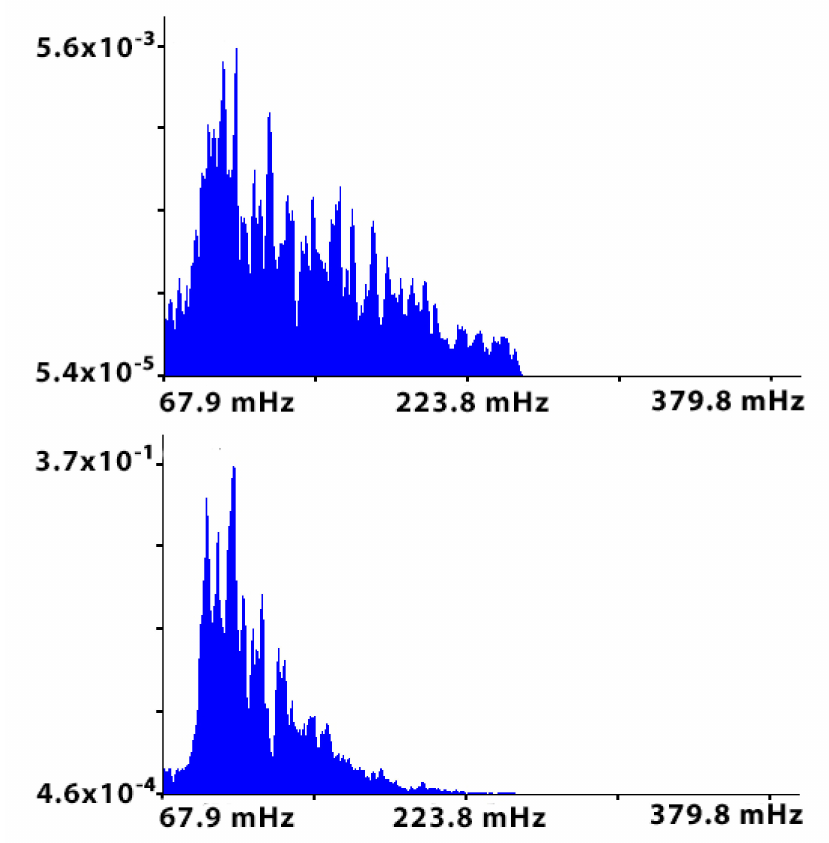
Figure 7. Spectra of synchronous fragments of laser strainmeter ( top ) and laser meter of hydrosphere pressure variations ( bottom ) records. Relative amplitudes are shown on the ordinate